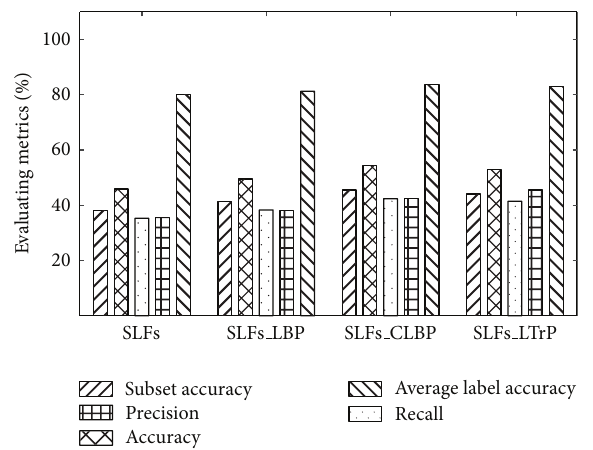
Figure 4: The comprehensive evaluation of entire dataset (348 proteins) based on db6 global features and local pattern